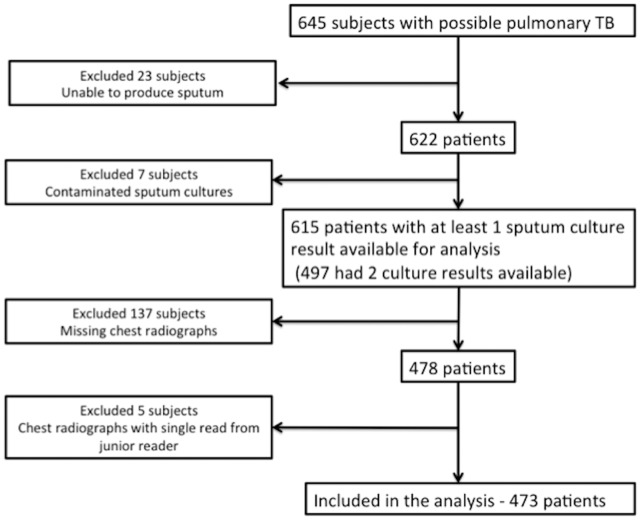
Patient flow diagram for the study.